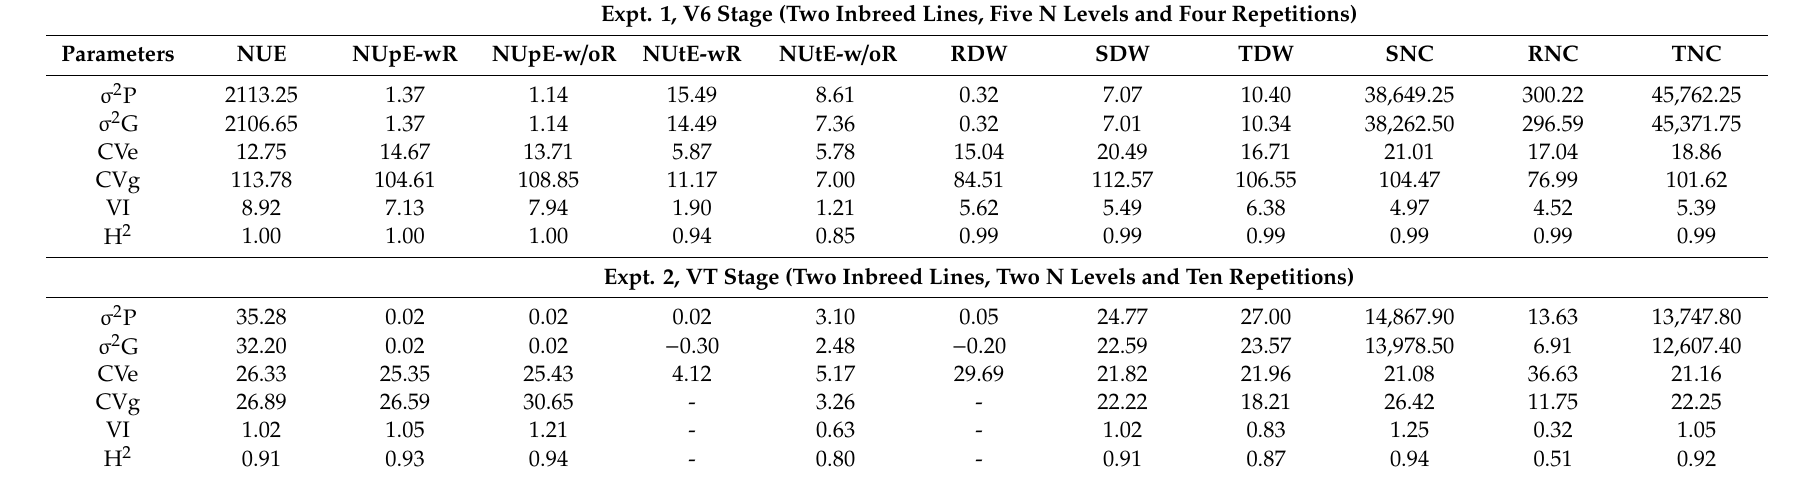
Table 6. Genetic parameters for dry weights, N content, nitrogen use, uptake and utilization e ffi ciency at the V6 and VT stage. Expt. 1, V6 Stage (Two Inbreed Lines, Five N Levels and Four